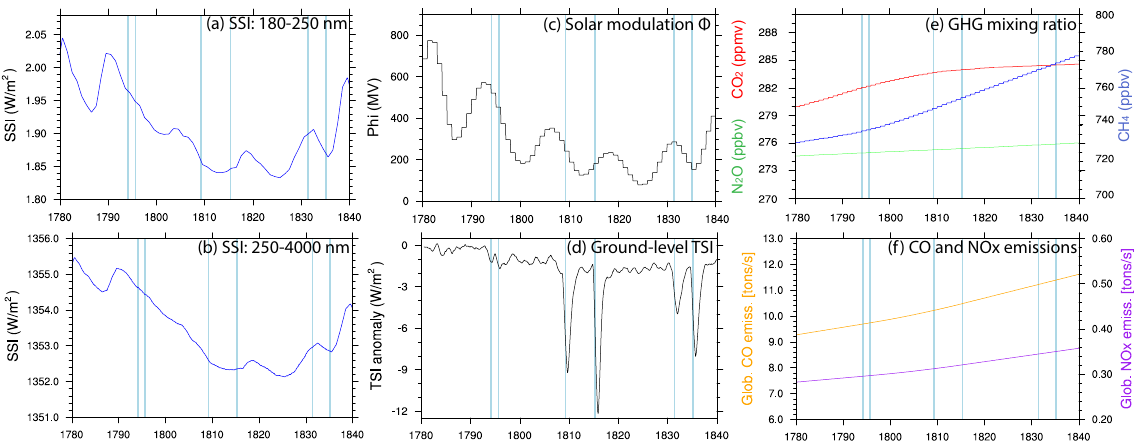
Fig. 1. Model forcing data over the Dalton Minimum (AD 1780–1840). (a) Spectral solar irradiance in the UV-C at 180nm <λ< 250nm. (b) Spectral solar irradiance at λ> 250nm. (c) Solar modulation potential following Steinhilber et al. (2008). (d) Ground-level TSI, showing anomalies relative to the 1780 unperturbed values. (e) Greenhouse gas mixing ratios for CO 2 , CH 4 and N 2 O. (f) Anthropogenic and natural CO and NO x emissions from fossil fuel burning. Blue vertical lines highlight the years in which a volcanic eruption